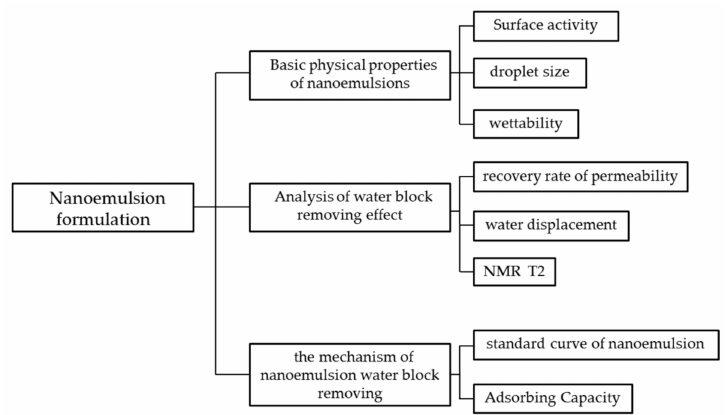
Figure 2. The flowchart of research